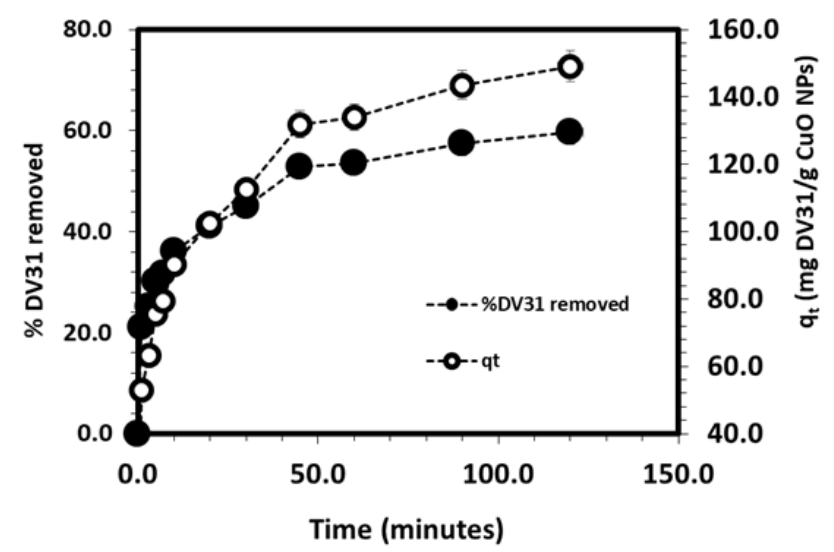
Figure 9. Effect of contact time on the removal of DV31 dye from aqueous solution using G CuO NPs. (Experimental conditions: DV31 dye concentration 25 mg/L; sample volume 200 mL; 20.0 mg CuO NPs; 1 mL H 2 O 2 ; pH 8.6 and temperature at 25 °C).